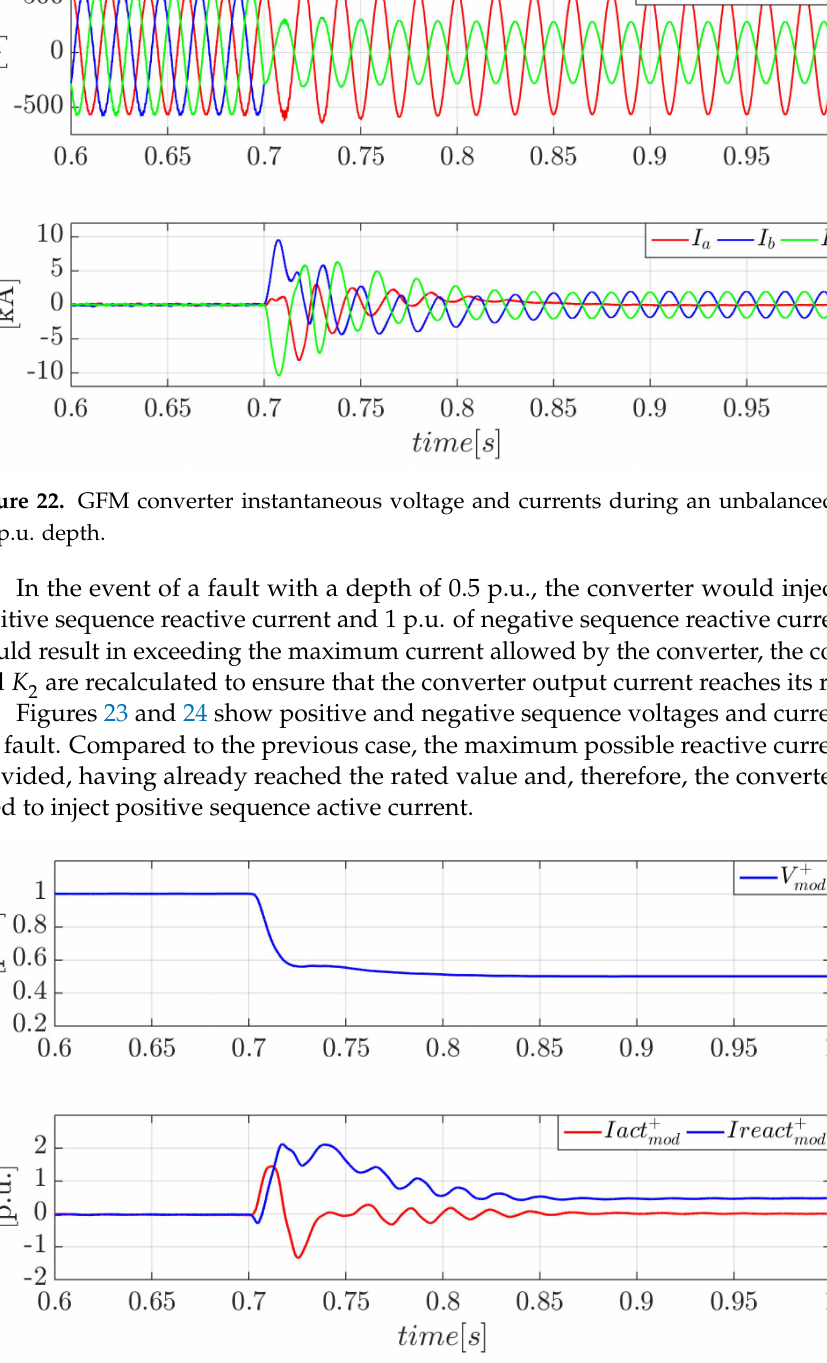
Figure 23. GFM converter positive sequence voltage and currents during an unbalanced fault with 0.5 p.u.